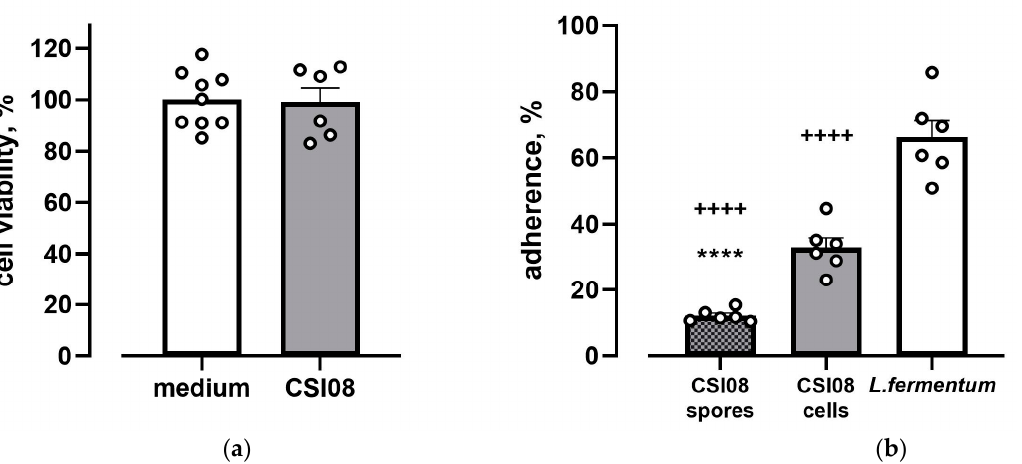
Figure 5. Interaction of B. clausii CSI08 with intestinal epithelial cells. ( a ) B. clausii CSI08 did not reduce HT-29 viability. Data represent percentage of XTT dye conversion after 20 h of coincubation with B. clausii CSI08 compared with untreated cells (medium). Values are means ± SEM of three independent experiments. ( b ) Adhesion of vegetative cells and spores B. clausii CSI08 to the HT-29-MTX. Values represent percentage of adhered cells/spores after 2.5 h of incubation with HT-29-MTX followed by four rounds of washing. Values are means (n = 6) ± SEM of three independent experiments **** p < 0.0001 vs. CSI08 cells, ++++ p < 0.0001 vs. L. fermentum .